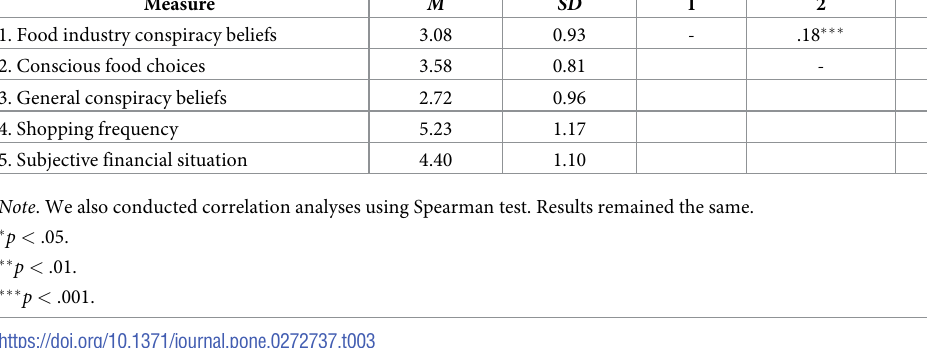
Table 3. Means, standard deviations, and zero-order correlations (Study 2). Measure